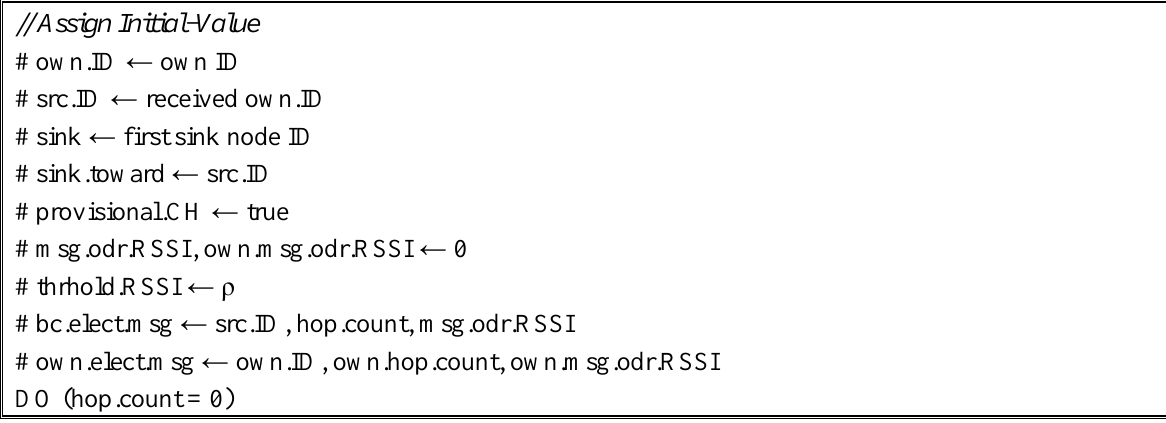
Algorithm 1. Proposed clustering algorithm to optimize energy